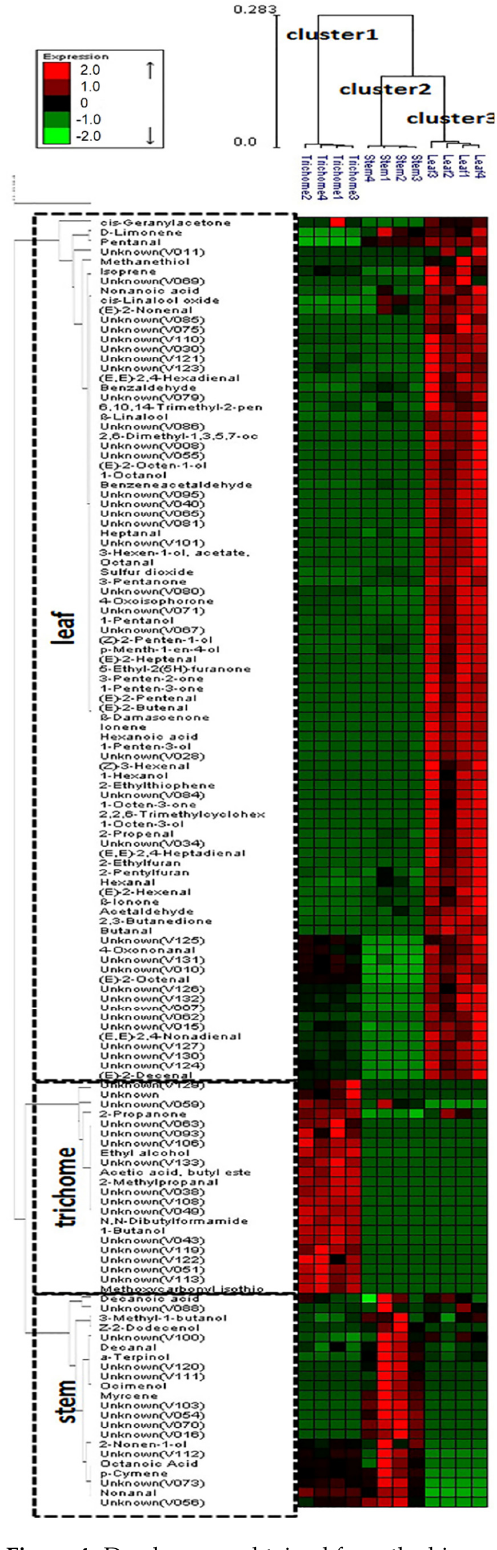
Figure 4. Dendrogram obtained from the hierarchical cluster analysis of plant tissue SPE-GC-MS data (i.e., glandular trichomes isolated from stems, trichome-free stems, and leaves of alfalfa plants) and 133 volatile metabolites using Expander package (ver. 6). The dendrogram provides distinct visualization of the differences in volatile metabolites emitted from the various plant tissues: cluster 1 (glandular trichome), cluster 2 (stem), and cluster 3 (leaf). The metabolites contributing to the separation of glandular trichome, stem, and leaf are also shown in the